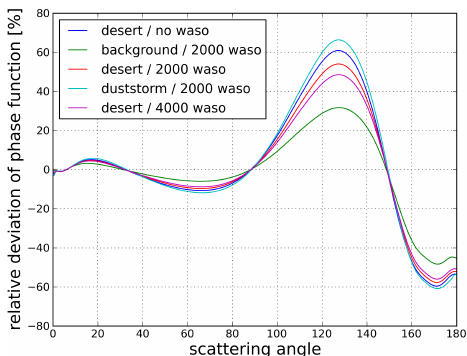
Figure 4. Relative deviations (%) of phase functions at 0.55µm, as- suming spheroidal mineral particles, from phase functions of spher- ical particles, for different combinations of the components WASO, MINM, MIAM and MICM (for details see